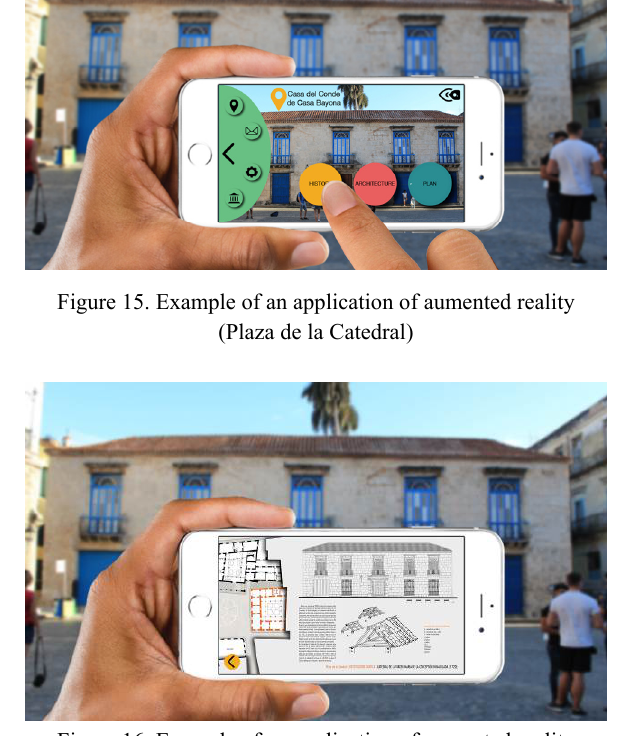
Figure 16. Example of an application of aumented reality